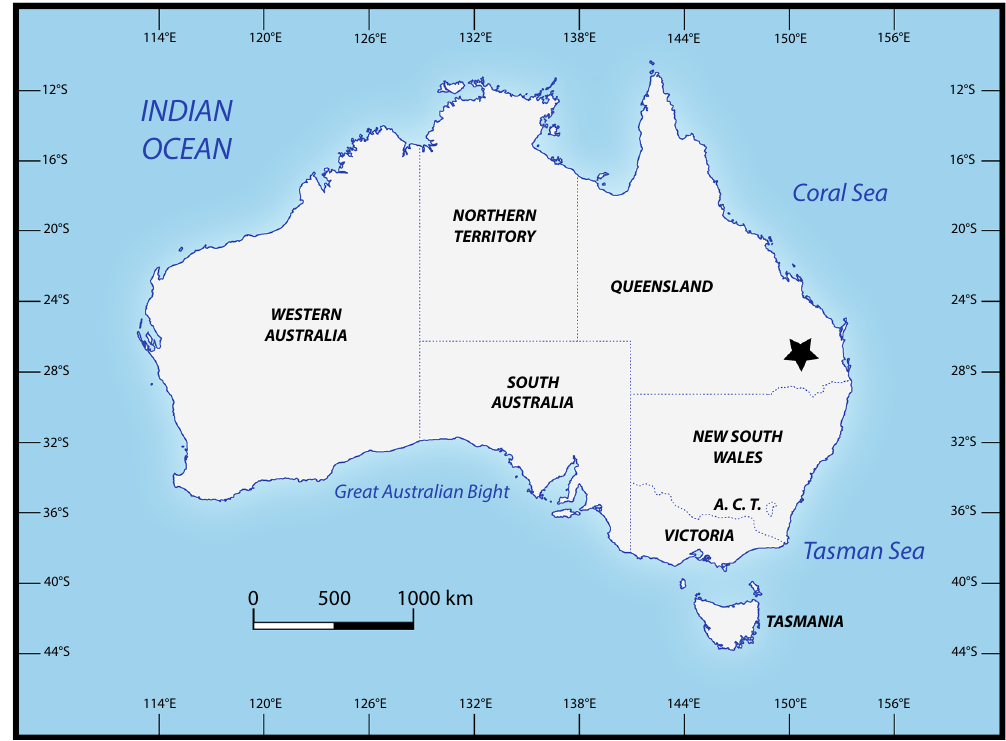
Figure 1. Map of Australia. The black star indicates the Darling Downs region, where the Gunggamarandu maunala gen. et sp. nov. holotype specimen, QMF14.548, was discovered. This map was drawn by J. R. in Adobe Illustrator CC 2021 (https:// www. adobe. com/ produ cts/ illus trator. html) based on data modified from SimpleMappr (https:// www. simpl emappr.